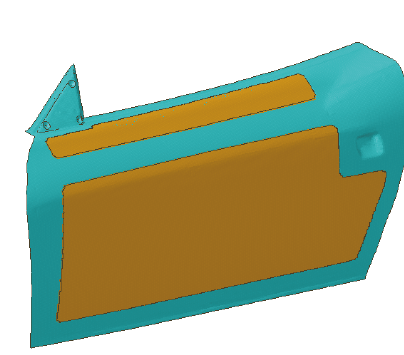
Figure 14: Comparison of the damped and undamped panels: position of the damping patches.